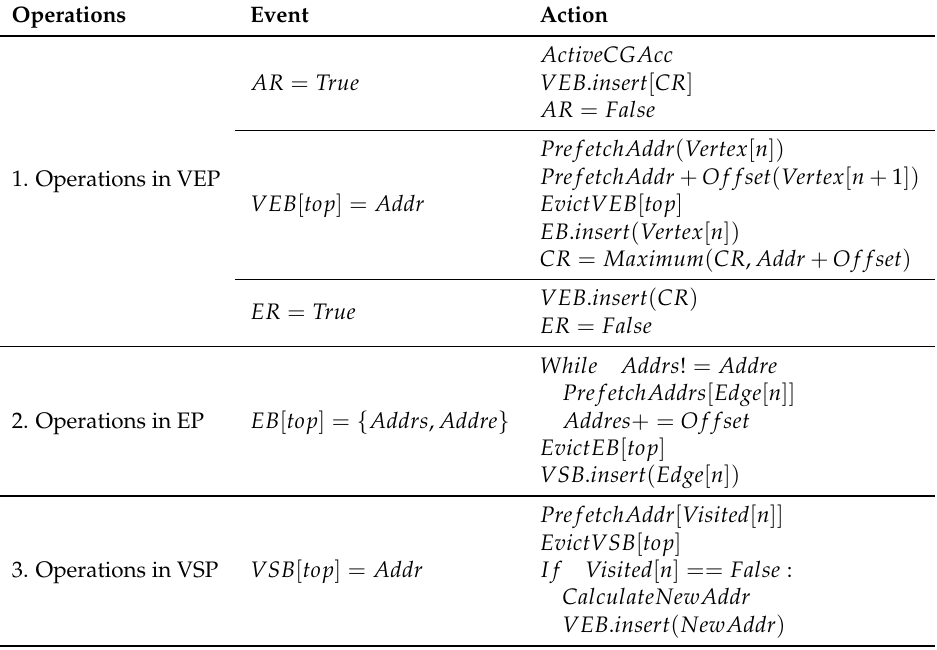
Table 2. Events that cause prefetcher actions. AR: Activation Register; CR: Continual Register; ER: End subgraph